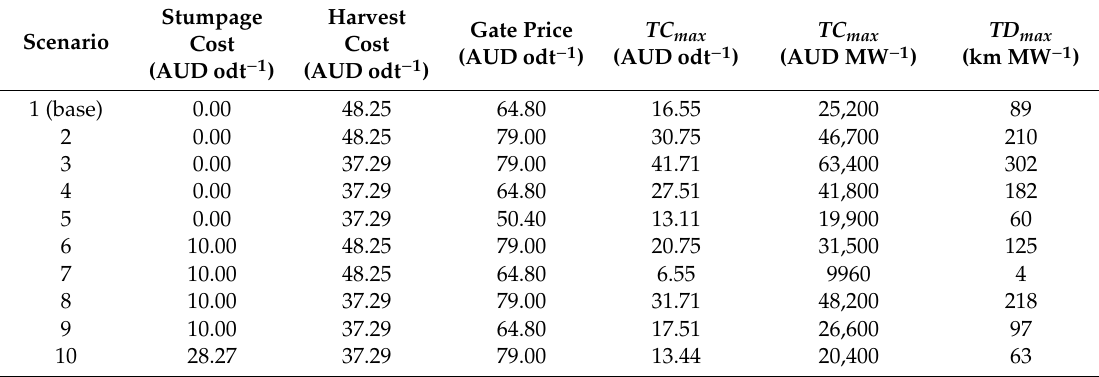
Table 2. Estimated maximum transport cost ( TC max ) and maximum allowable transport distance ( TD max ) values for a range of scenarios based on changes in gate price, stumpage and harvest costs.